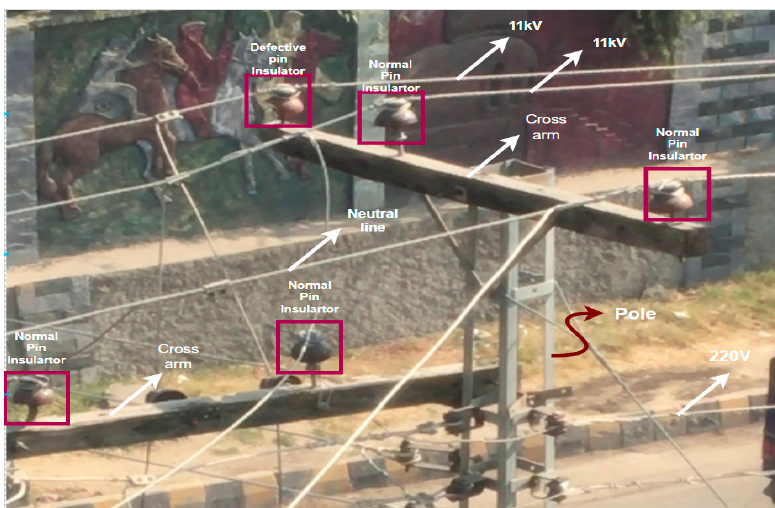
Figure 4. Power system components mounted on a supporting electric pole.